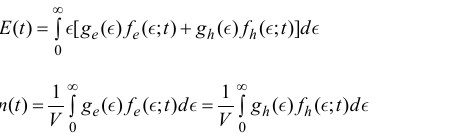
Figure 4. Gain-absorption spectrum of CdS in pump-probe experiment. Values of the laser power I , reservoir temperature T carrier concentration n , carrier quasitemperature T * , and reciprocal of the carrier lifetime, Γ, are shown in the upper left inset. The position of the renormalized band gap is indicated. (Motisuke 68 ).